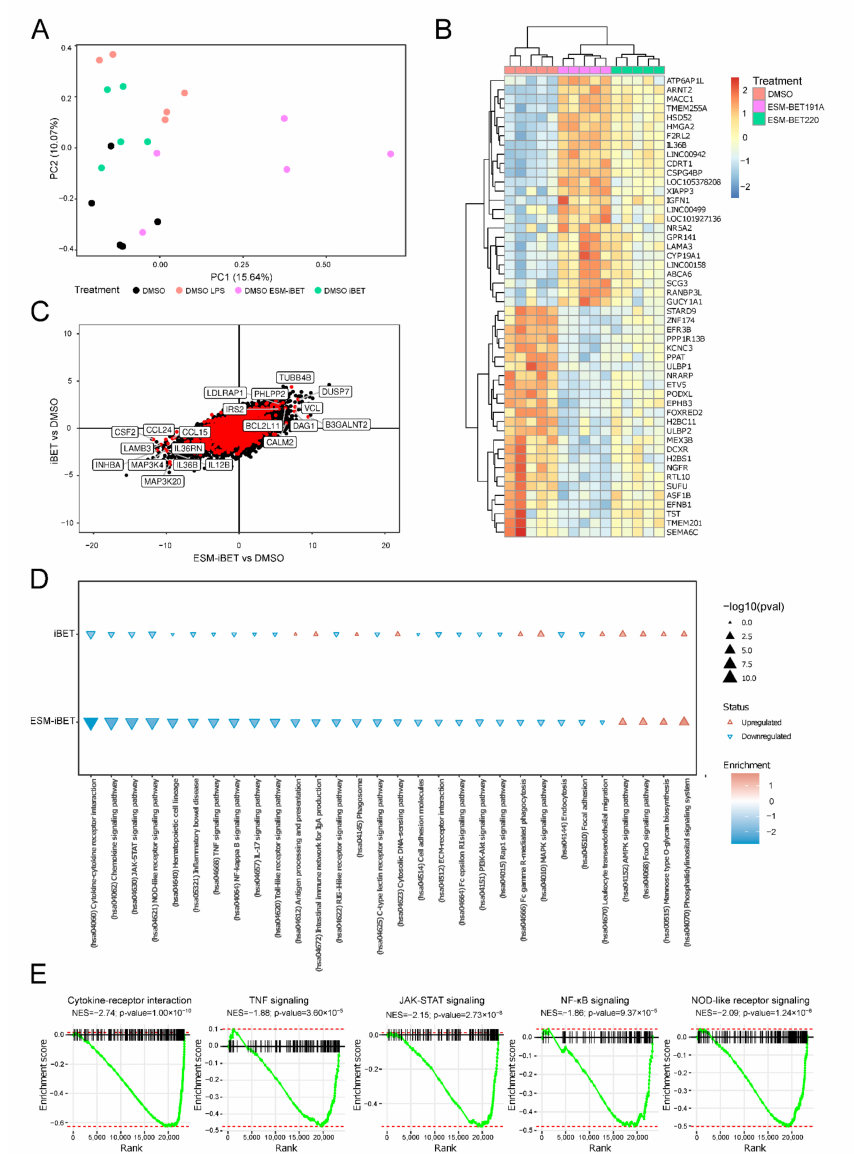
Figure 5. ESM-iBET influences the transcription of inflammatory related genes and pathways with increased potency over iBET in blood CD14 + monocytes. ( A ) RNA sequencing data of pe- ripheral CD14 + monocytes (n= 5 healthy donors) pre-treated for 1 h with DMSO, 40 nM ESM-iBET (GSK33611910), or 40 nM iBET (GSK3235220), then stimulated with LPS (4 h). Principle compo- nent analysis is shown. ( B ) A heat map depicting the top 20 up- and downregulated genes when comparing BET inhibitors vs. DMSO. Colors represent the scaled log2 (counts). ( C ) Comparison of the Wald statistic obtained from DESeq2 when comparing ESM-iBET with DMSO, and iBET with DMSO on the x- and y-axes, respectively. In red are genes that encode proteins involved in the inflammation-related pathways; highlighted genes are the top 10 up- and downregulated genes (DEGs), comparing ESM-iBET (n = 5) vs. DMSO (n = 5) pre-treated, LPS-stimulated monocytes. ( D ) Gene set enrichment analysis (GSEA) of inflammation-related pathways with functional anno- tation using Kyoto Encyclopedia of Genes and Genomes (KEGG) pathways, the direction of the arrow indicates either up- or downregulation, while the size and shading of the arrow represent the –log10 ( p -value) and normalized enrichment score, respectively. ( E ) Enrichment scores of the cytokine–cytokine receptor interaction, TNF signaling, JAK-STAT signaling, NF-kB signaling, and NOD-like receptor signaling pathways in the CD14 + monocytes (n = 5 healthy donors), pre-treated for 1 h with DMSO, ESM-iBET (GSK33611910), or iBET (GSK3235220), then stimulated with LPS (4